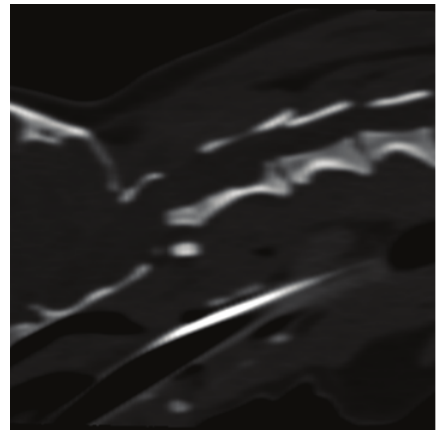
Figure 2: Sagittally reconstructed CT image showing the atlantoax- ial subluxation and small mineral fragment cranial to the dens